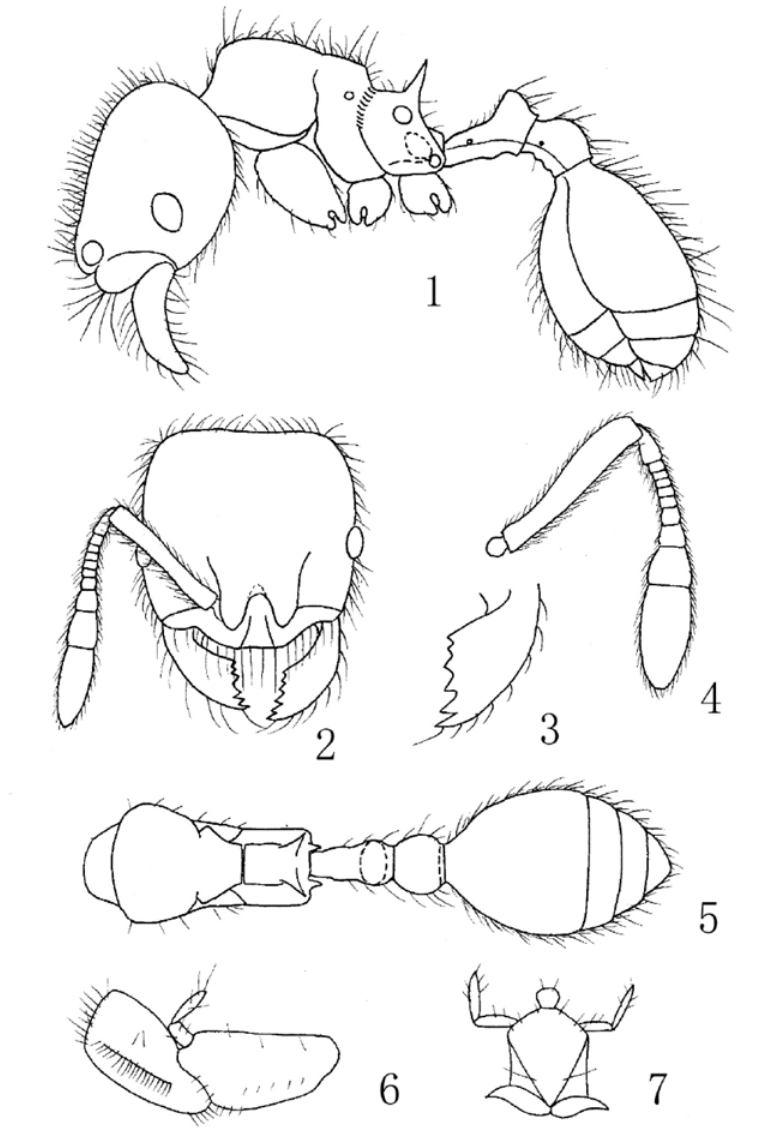
Figs. 1-7: Worker of Gaoligongidris planodorsa sp. nov.; 1. Head and body in profile view; 2. Head in full face view; 3. Mandible in dorsal view; 4. Antenna in dorsal view; 5. Body in dorsal view; 6. Maxilla and maxillary palp in ventral view; 7. Labium and labial palp in ventral